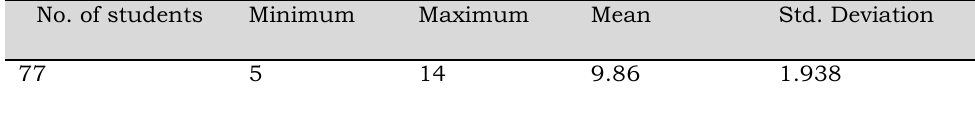
Table 1. Descriptive statistics of the prosodic reading